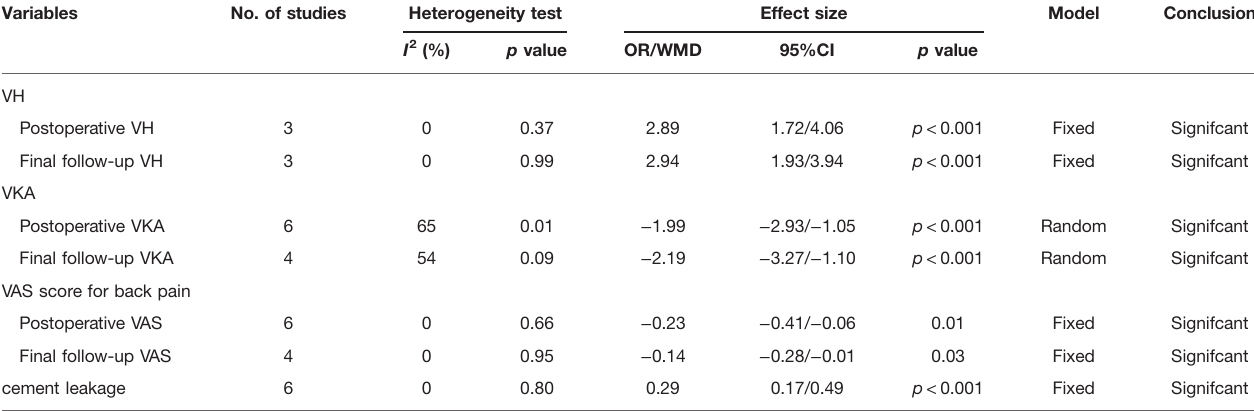
TABLE 3 | Summarized results of robotic-assisted kyphoplasty versus fl uoroscopy-assisted kyphoplasty. Variables